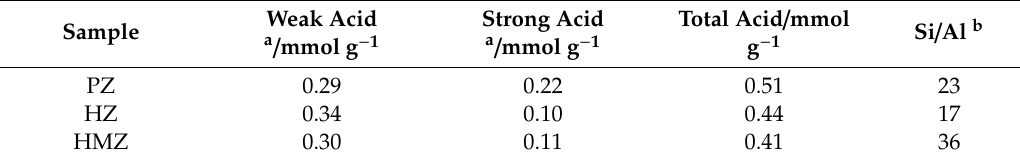
Table 2. Acidity properties and surface Si/Al ratio of samples.